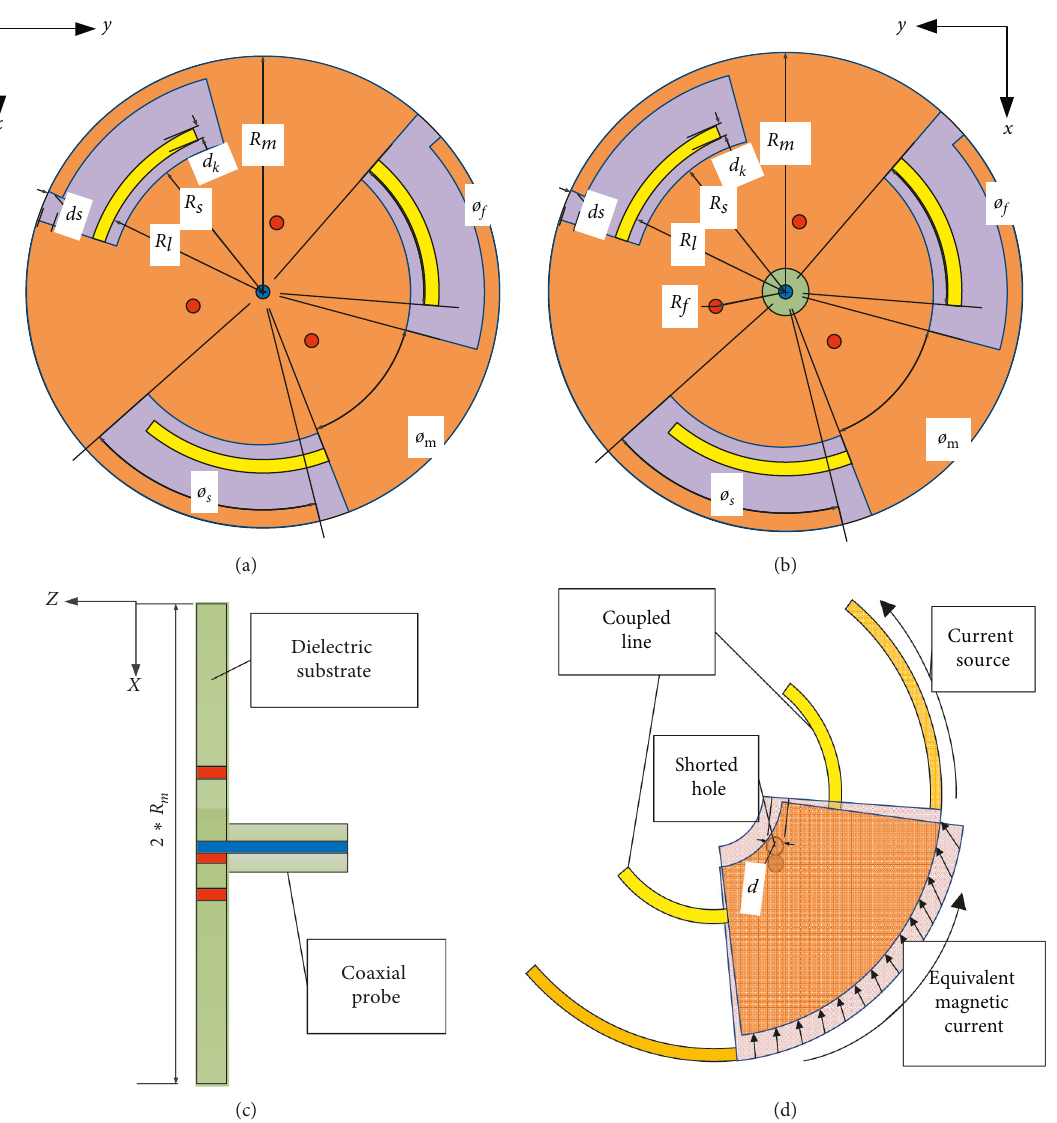
Figure 1: Geometry of the proposed omnidirectional CP antenna: (a) top layer; (b) bottom layer; (c) side view; (d) unit